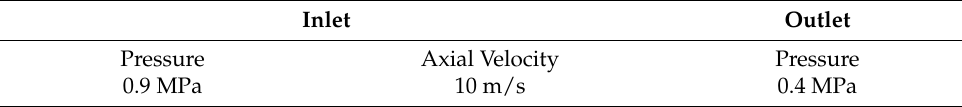
Table 1. The boundary conditions.